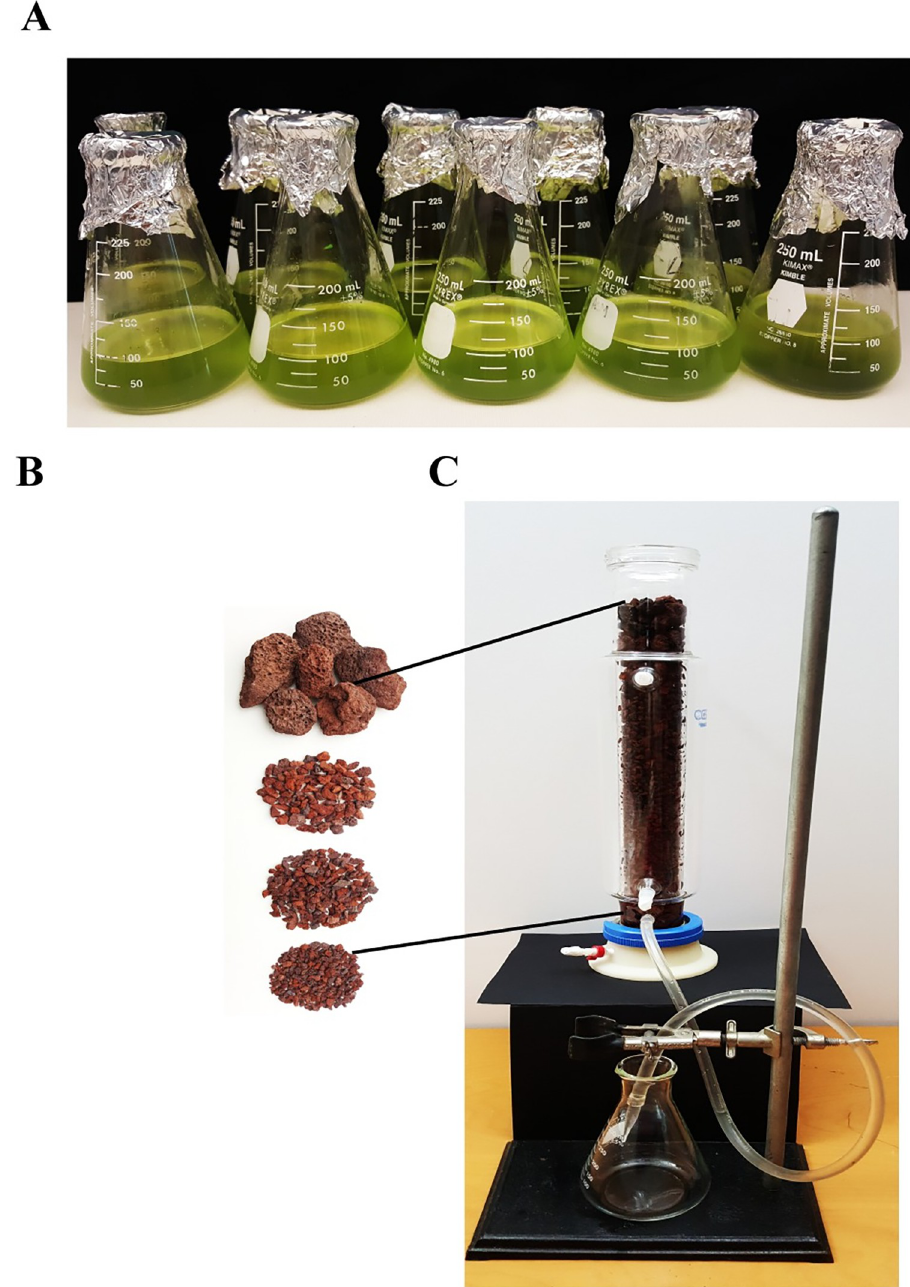
Fig 1. Gravity filtration of Synechococcus sp. PCC 7002 cultured in briny water simulant through basalt-type volcanic rocks. (A) Flasks containing Synechococcus sp. PCC 7002 grown briny water simulant. (B and C) Image of basalt-type volcanic rocks packed in a glass column with largest particles (~60 mm) at the top, smallest particles (~ 6 mm) at the bottom and intermediate particles in between. Final filtrate was collected and used to grow plants.